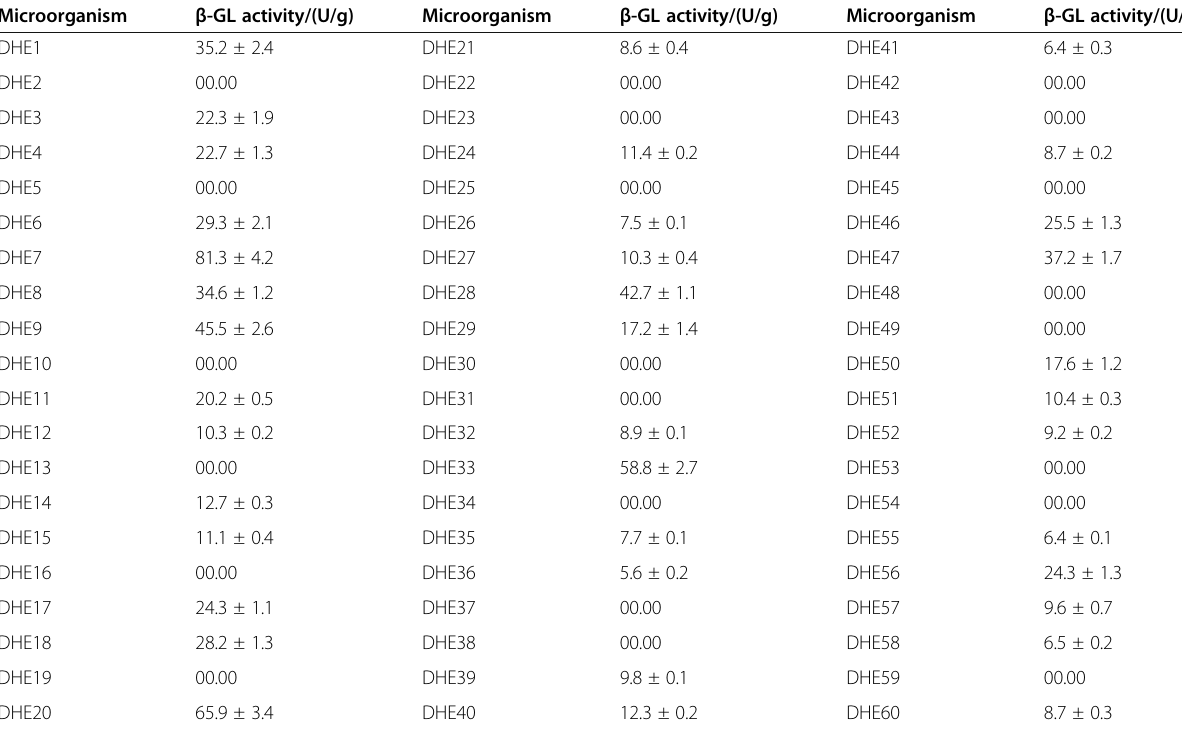
Table 1 Screening of different fungal isolates for extracellular β -glucosidase ( β -GL) production (on dry mass) under solid state fermentation using wheat bran as substrate Microorganism β -GL activity/(U/g) Microorganism β -GL activity/(U/g)